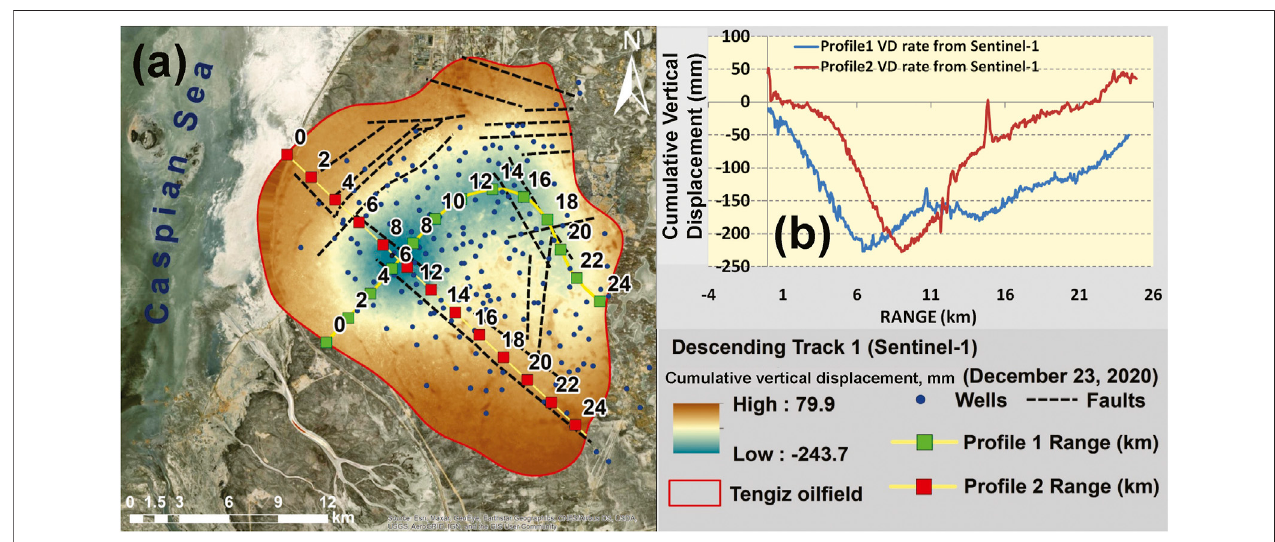
FIGURE 7 | (A) Map of cumulative vertical displacement derived from the Sentinel-1 images with the indication of pro fi le lines; (B) pro fi le lines of cumulative vertical displacement.